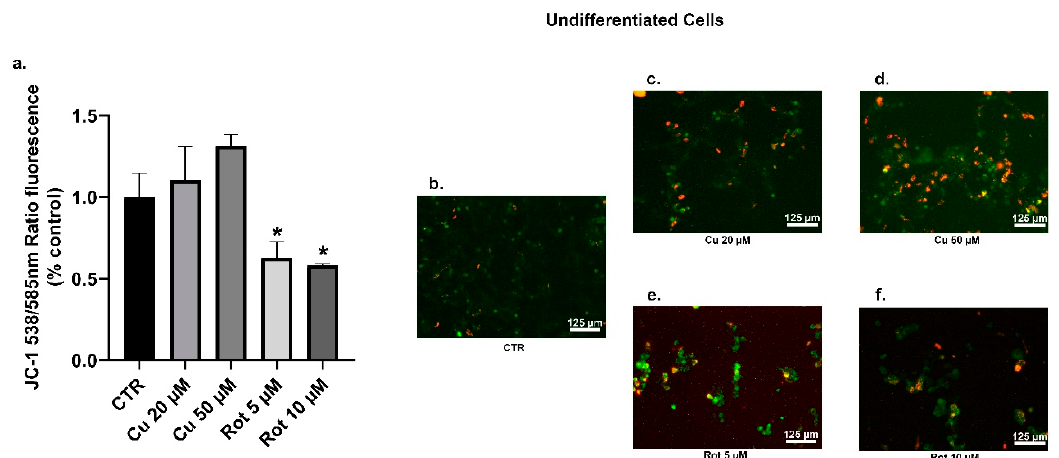
Figure 12. Undifferentiated SHSY5Y cells JC-1 analysis. The JC-1 staining was used to assess the mitochondrial membrane potential (MMP) cells were treated with 20 or 50 μ M copper ( c , d ) or 5 or 10 μ M rotenone ( e , f ) and compared to untreated cells ( b ). The percentages of JC-1 monomers presented the percentages of SHSY5Y cells with low MMP. Fluorescence values were normalized on total protein ( a ). Values were compared with untreated cells (CTR) by one-way ANOVA following Tukey test * p < 0.0332.